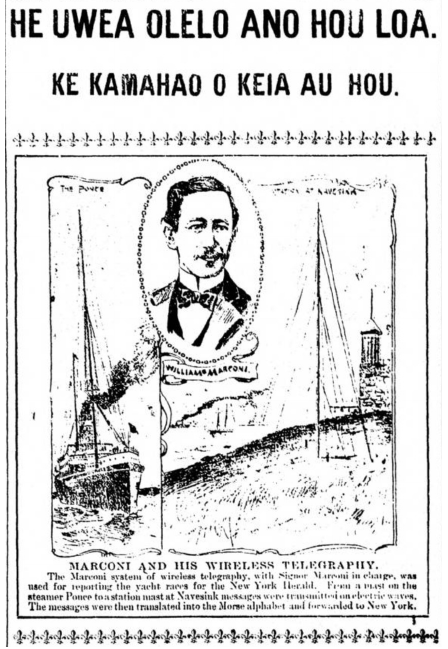
Figure 3: Clipping from November 10, 1899, edition of Ka Nupepa Kuokoa . The image and headline accompanied a Hawaiian-language article focused on wireless telegraphy and F. J. Cross’s Marconi franchise. Source: Papakilo